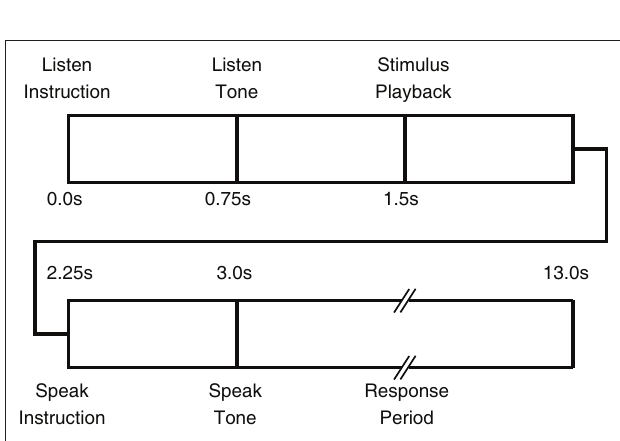
Figure 3 | Timing of training paradigm for phoneme detection trials is as follows: [1] “listen” instruction ( t = 0 s), [2] “listen” tone (acoustic, t = 0.75 s), [3] acoustic stimulus presentation ( t = 1.5 s), [4] “speak” instruction ( t = 2.25 s), [5] “speak” tone ( t = 3.0 s), and [6] subject is instructed